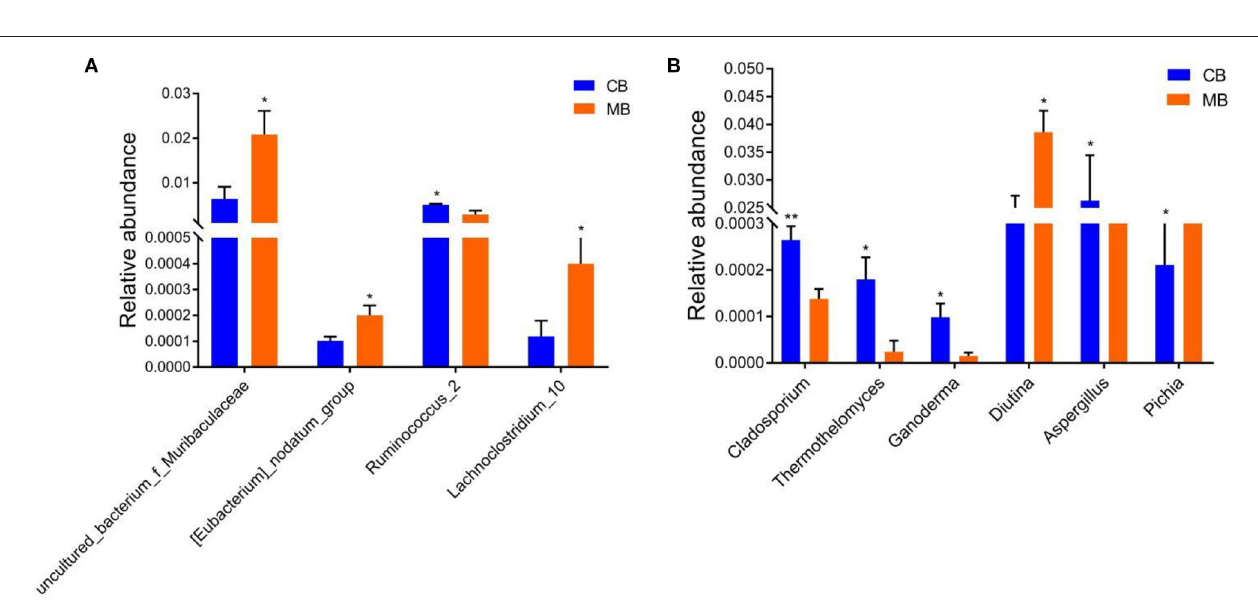
FIGURE 4 | The network diagram visualizes correlations between different bacterial genera. The orange lines indicate a positive correlation and the green lines indicate a negative correlation.